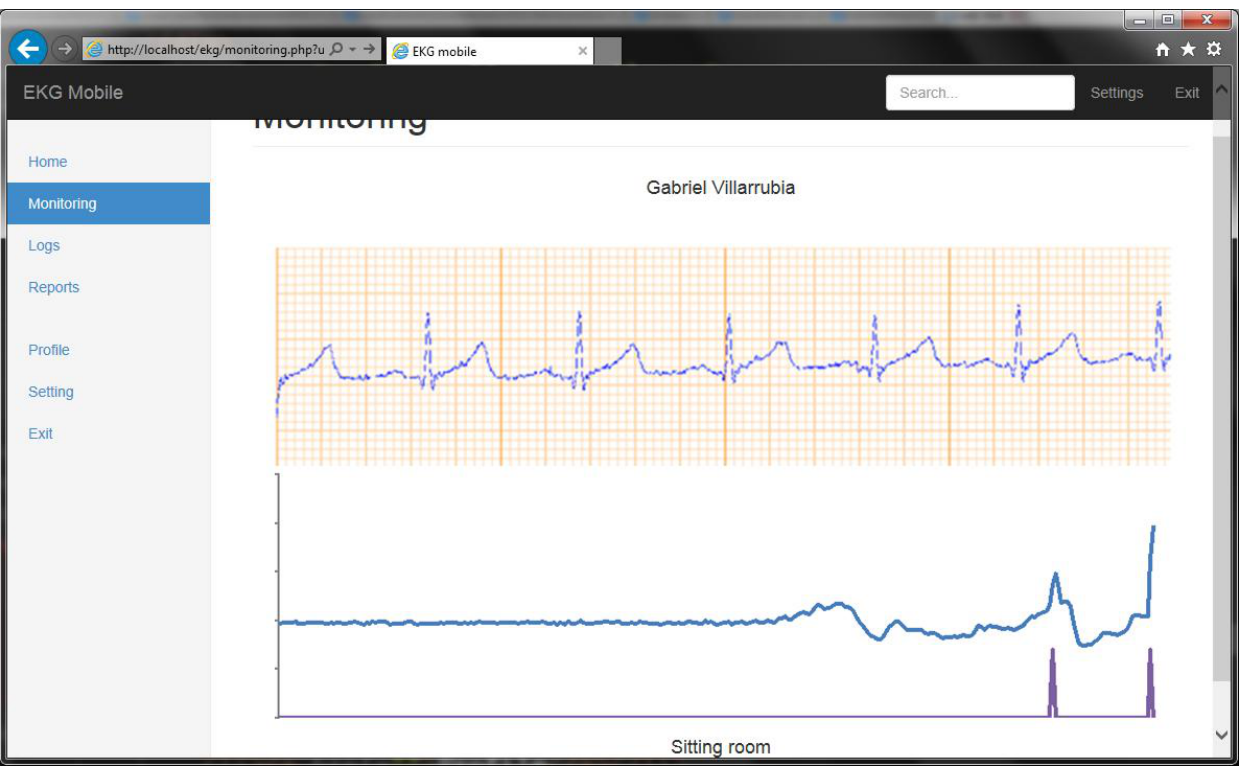
Figure 13. Remote monitoring of the user